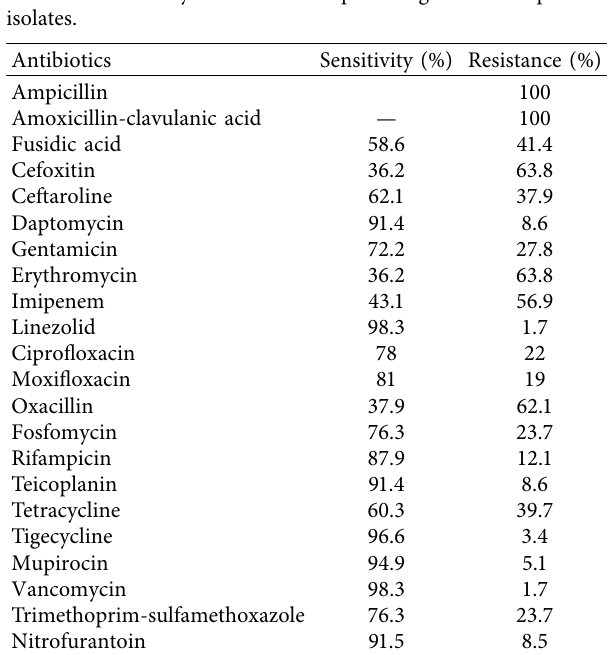
Table 4: Sensitivity and resistance percentage of Gram-positive